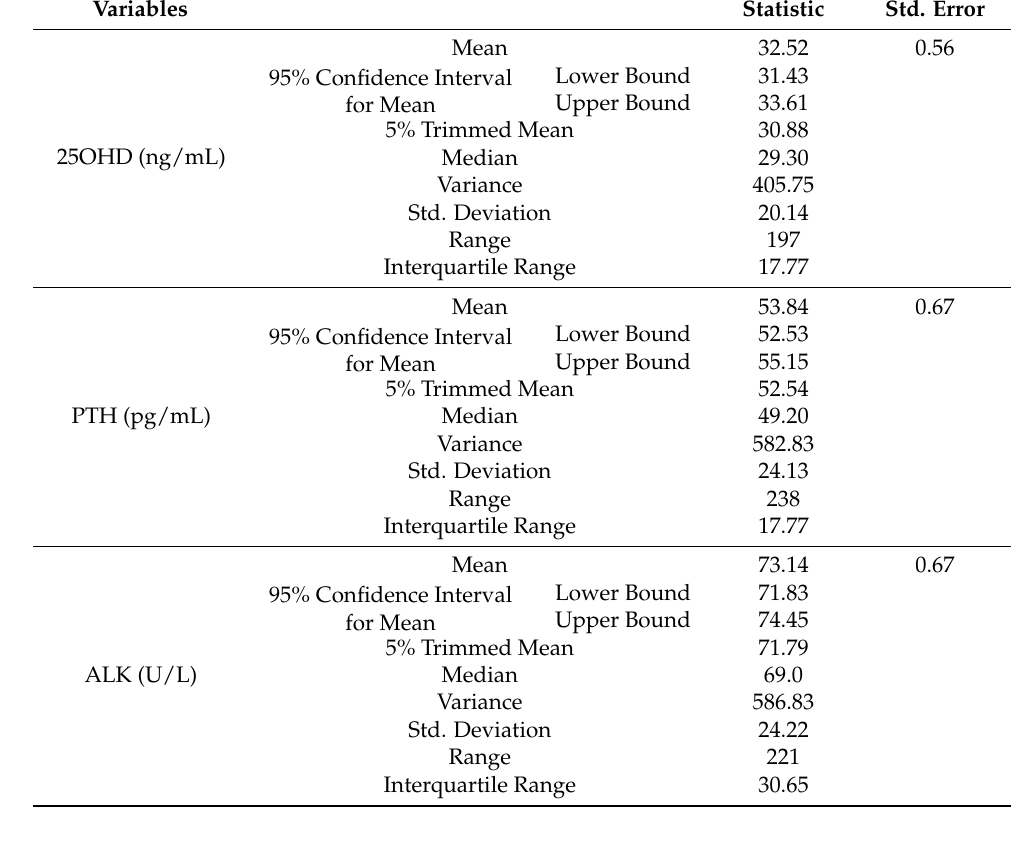
Table 1. Descriptive analysis (N = 1311).